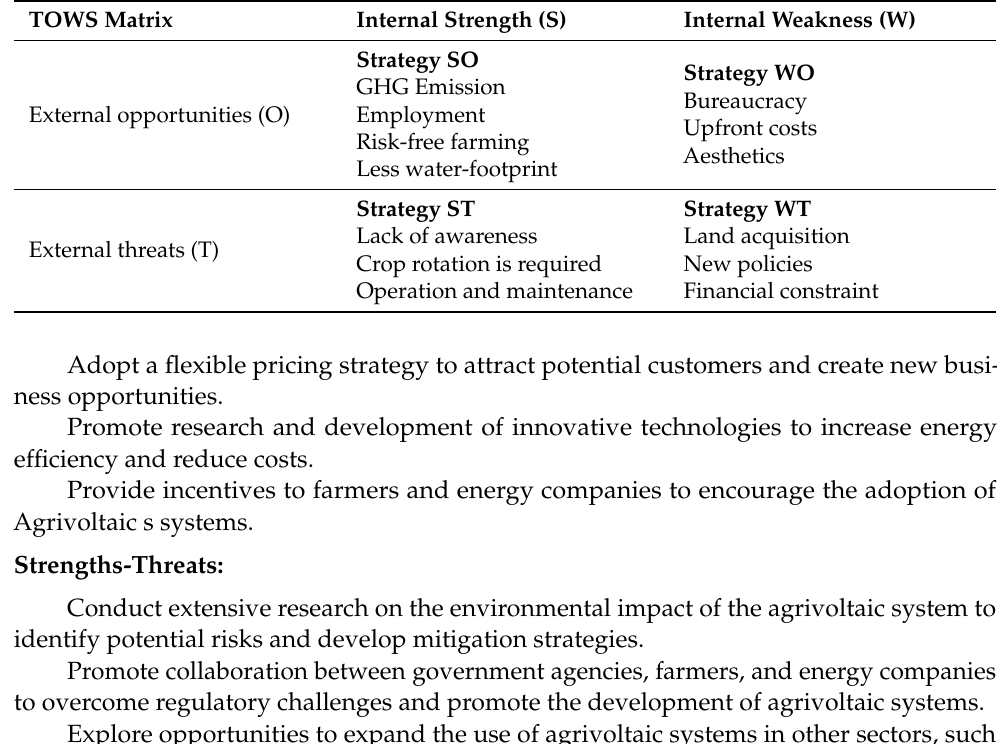
Table 2. Summary of TOWS